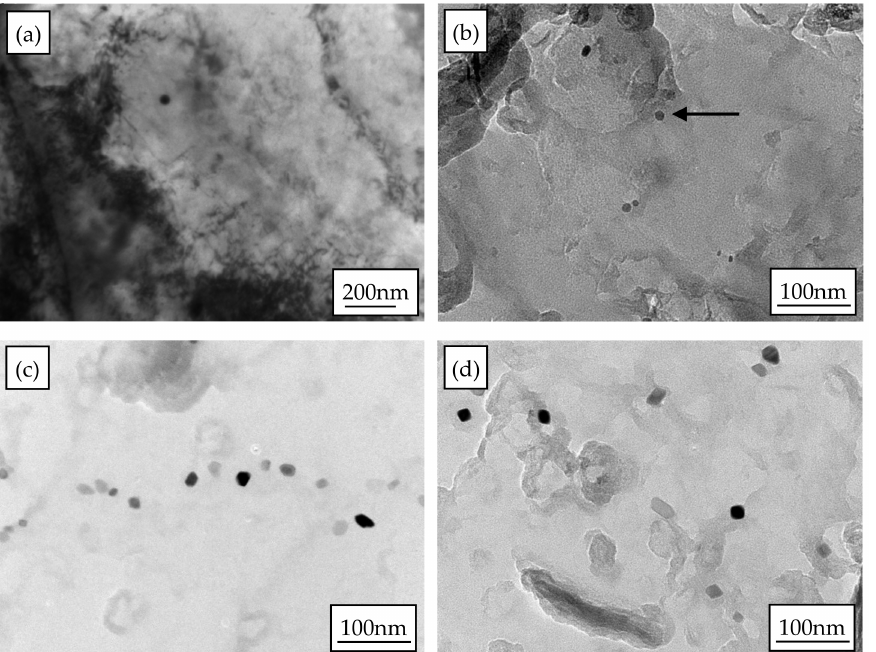
Figure 8. TEM images of strain-induced precipitates in experimental steel with different interruption times at deformation temperature of 900 ◦ C: ( a ) 20 s, foil sample, ( b ) 20 s, carbon replica sample, ( c ) 50 s, carbon replica sample, and ( d ) 100 s, carbon replica